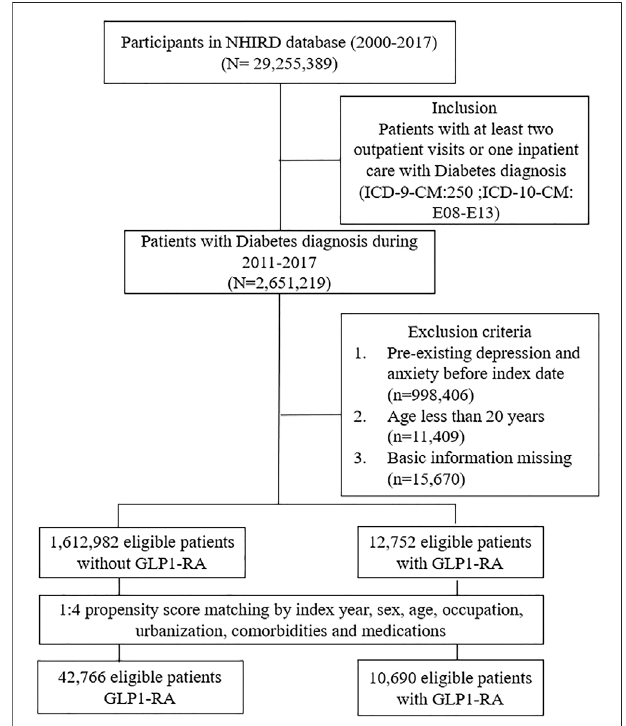
FIGURE 1 | Selection scheme for study